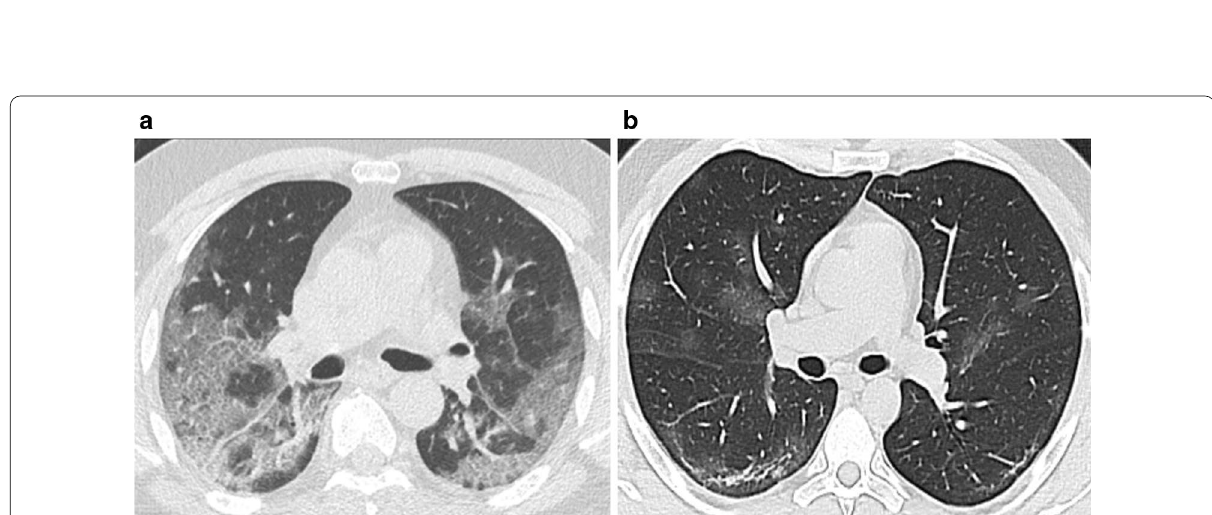
Fig. 2 Typical CT imaging features for COVID‑19. a A 72‑year‑old woman with positive RT‑PCR test, axial CT image shows multifocal peripheral GGO with superimposed interlobular septal thickening and visible intralobular lines (“crazy‑paving”). b A 46‑year‑old man with a positive RT‑PCR, axial CT image shows bilateral multifocal rounded and peripheral GGO with bilateral posterior subpleural